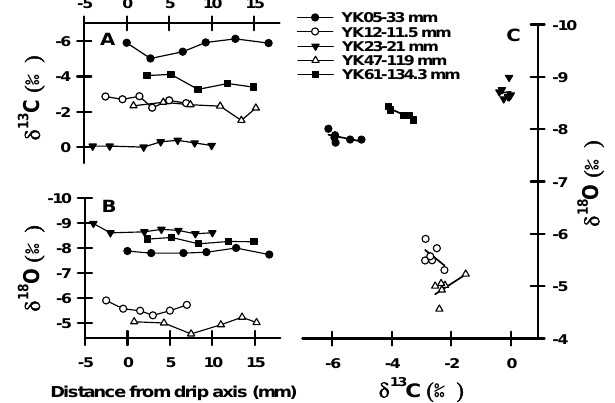
Figure 4. Hendy test on the arbitrarily selected laminae of five sta- lagmites with coeval data of (A) δ 13 C and (B) δ 18 O. (C) Plots of δ 18 O versus δ 13 C for coeval